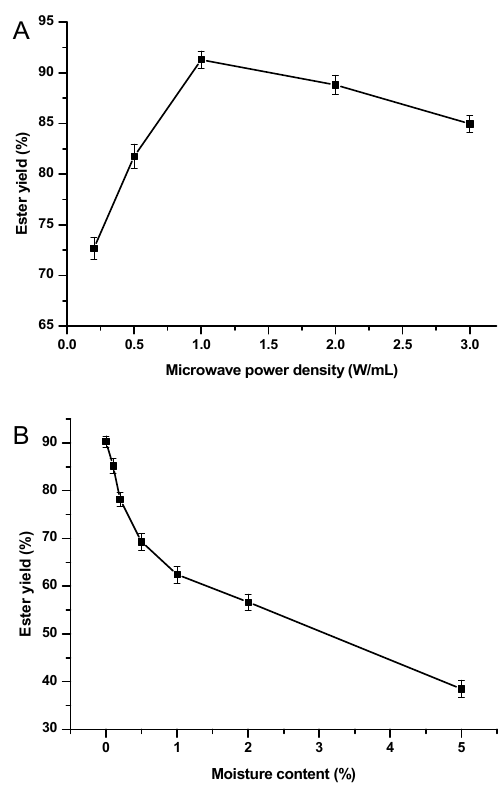
Figure 3. Effect of microwave power density ( A ) and moisture content ( B ) on ester yield. ( A ) reaction time, 15 min; ( B ) microwave power density, 1 W/mL, reaction time, 15 min.